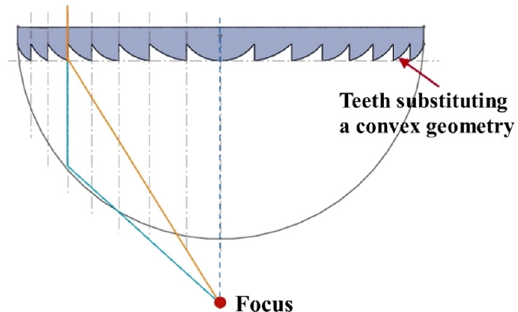
Figure 3: A diagram that simpli fi es the geometry of a Fresnel lens based on a convex